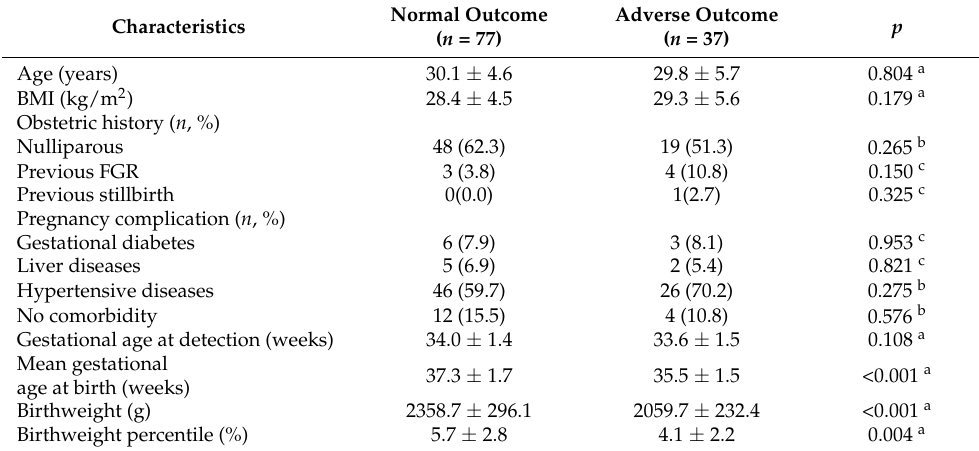
Table 1. Maternal characteristics of the enrolled pregnancies with late-onset FGR.